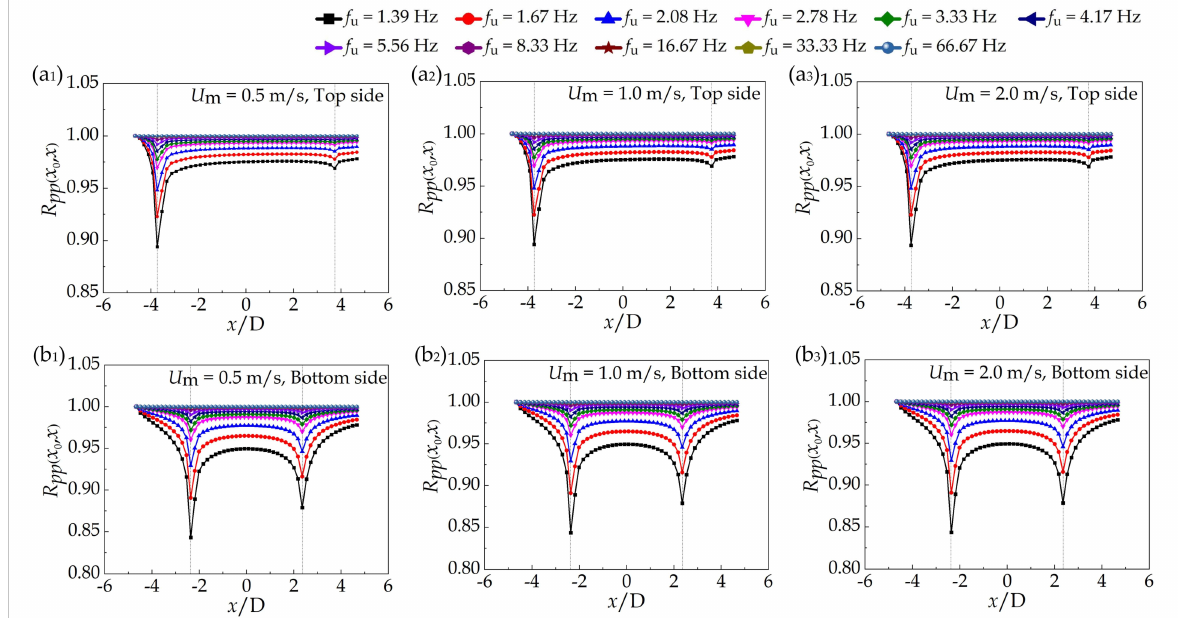
Figure 9. Streamwise correlation of pressure coefficients in streamwise sinusoidal flows: ( a 1 ) U m = 0.5 m/s, top side; ( a 2 ) U m = 1.0 m/s, top side; ( a 3 ) U m = 2.0 m/s, top side; ( b 1 ) U m = 0.5 m/s, bottom side; ( b 2 ) U m = 1.0 m/s, bottom side; ( b 3 ) U m = 2.0 m/s, bottom